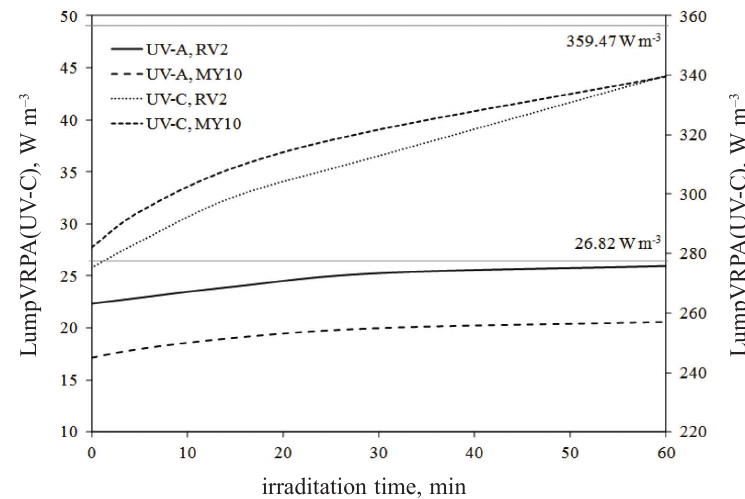
Fig. 5 – Time dependence of the LumpVRPA in the cylindri- cal reactors BRa at 365 nm and BRb at 254 nm due to the change in dye and intermediates concentration during the ap- plied process